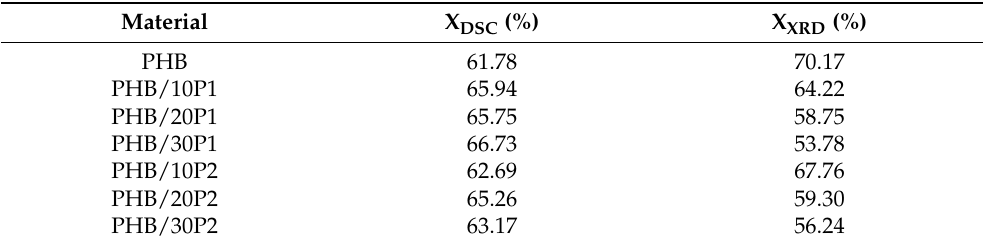
Table 4. Calculated crystallinity index of PHB, PHB/P1, and PHB/P2 blends using DSC (X DSC ) and XRD (X XRD )